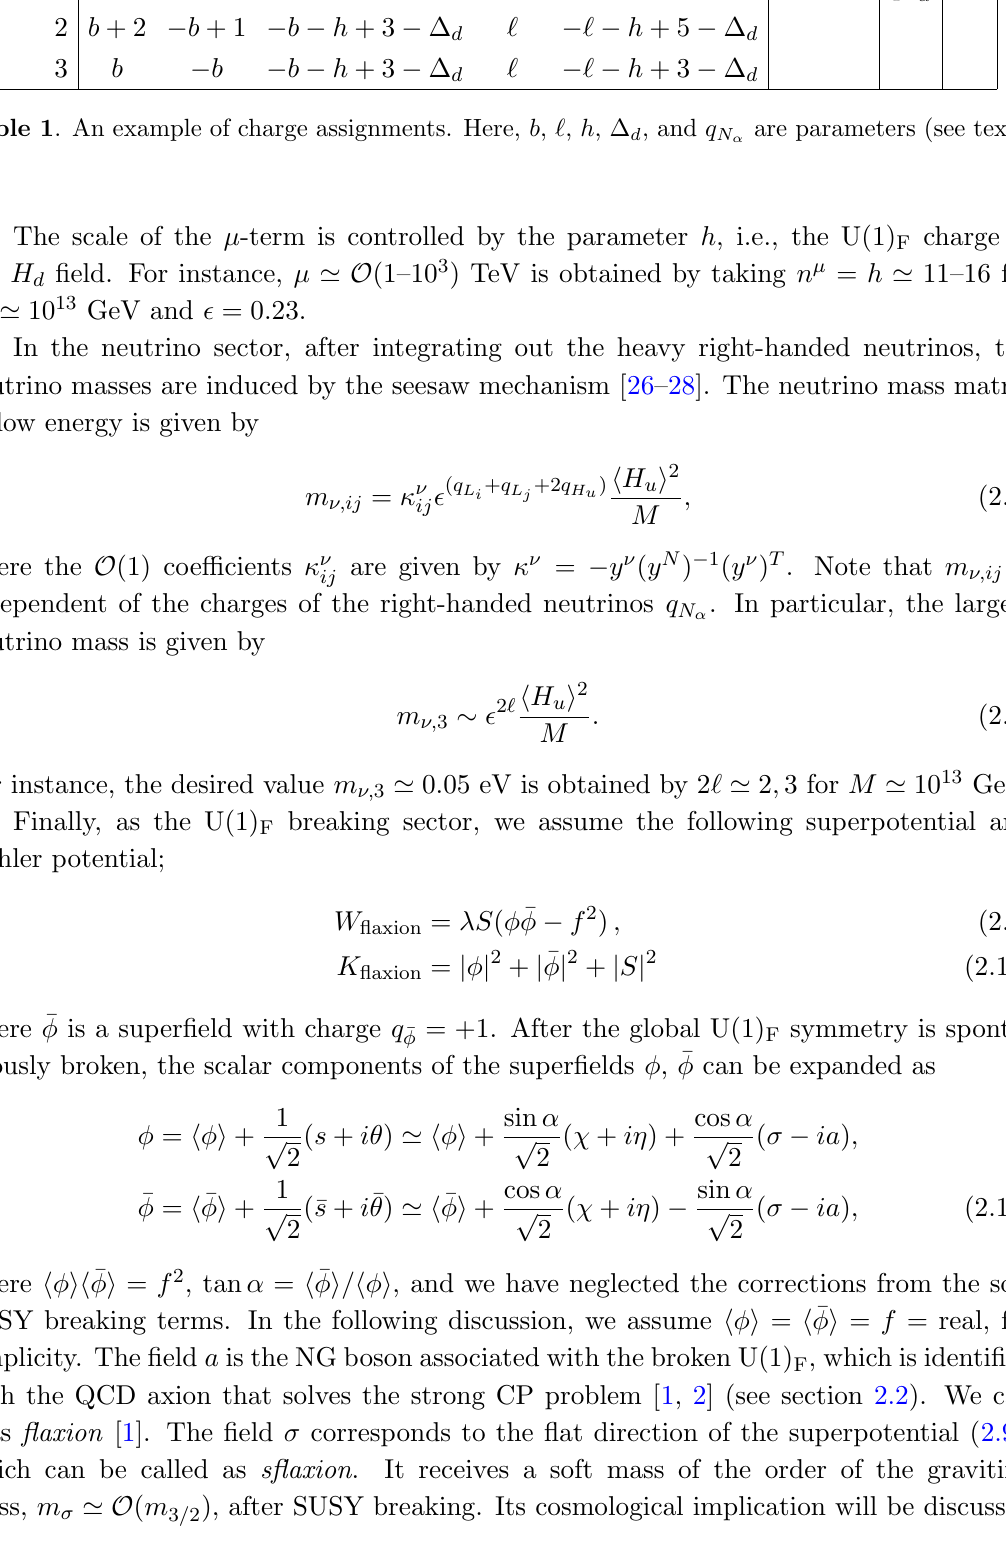
Table 1 . An example of charge assignments. Here, b , ‘ , h , (cid:1) d , and q N